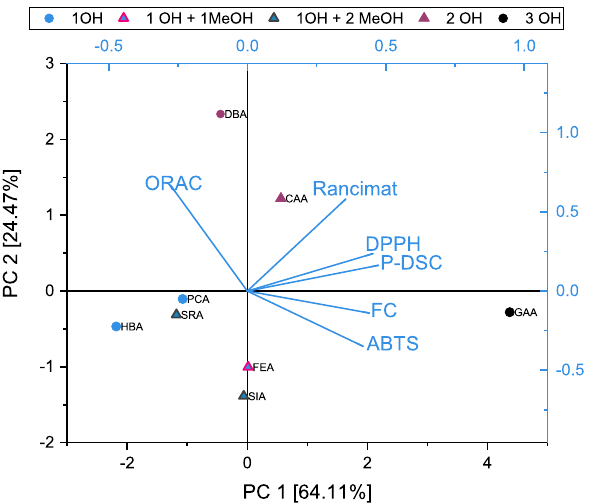
Figure 5. PC analysis of results of phenolic acids from Rancimat and the P-DSC, ABTS, DPPH, FC, and ORAC assays presented in dependence of hydroxyl and methoxy